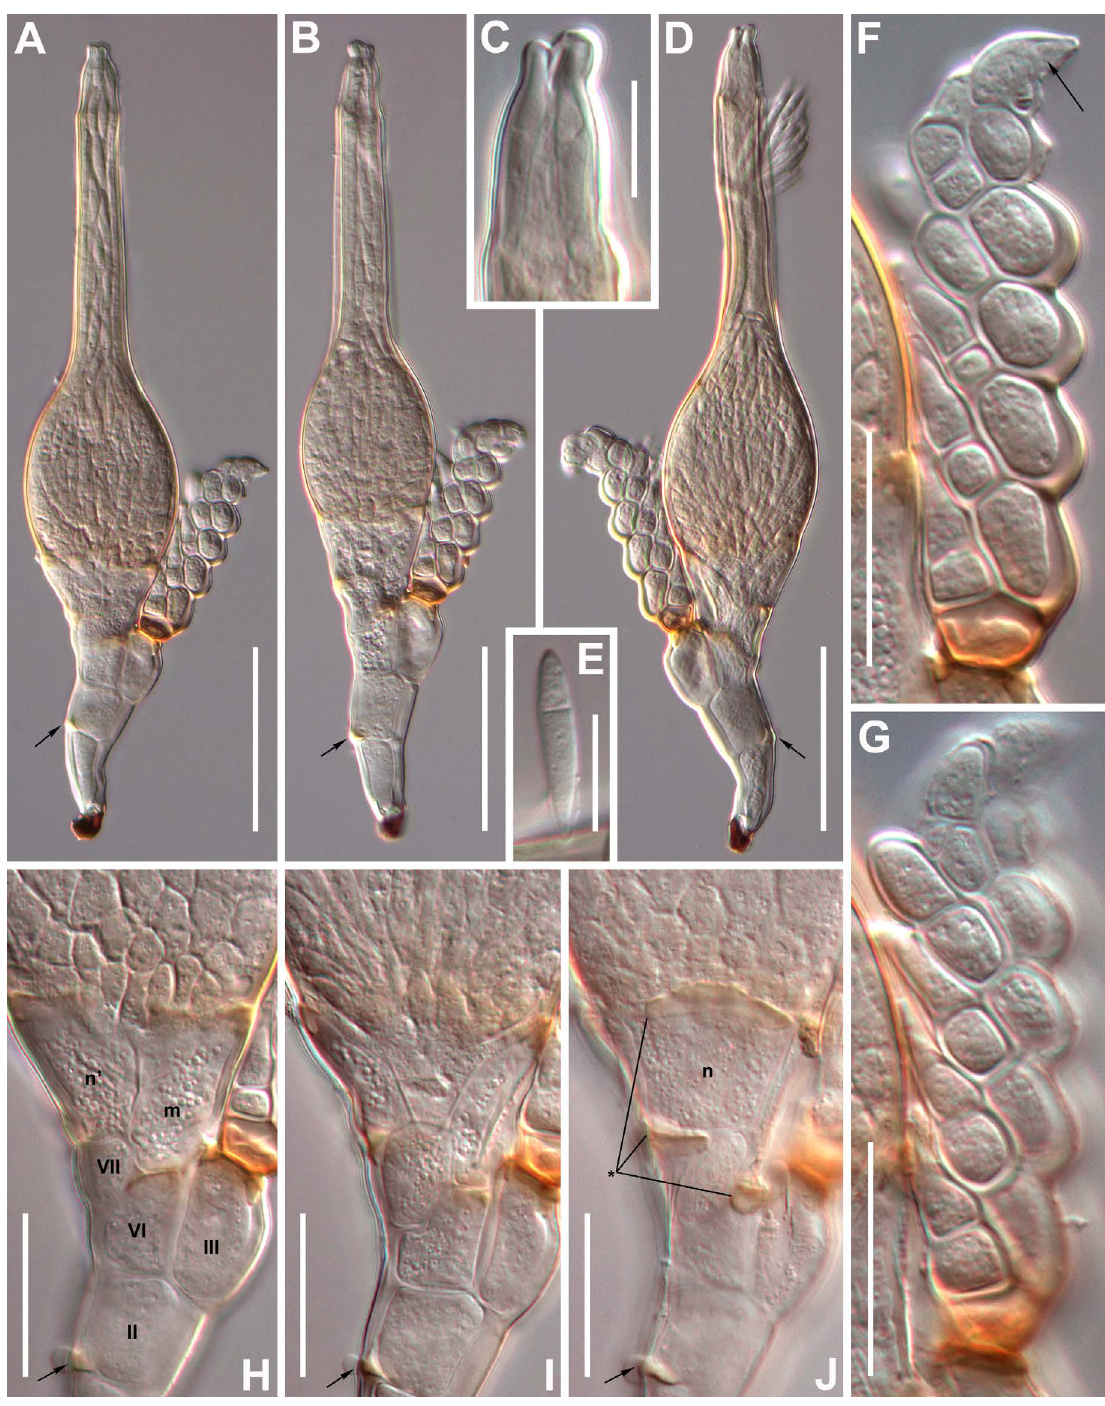
Fig. 62. Stigmatomyces thoracochaetae Santam. sp. nov. A – B , D . Mature thalli showing brown wall thickening on the lower ventral side of cell II (arrows). C . Perithecial apex in detail. E . Ascospore. F – G . Primary appendage in detail; in F the arrow points to uppermost axial antheridium-like cell which is oriented strongly backwards. H – J . Receptacle and lower area of perithecium in detail at three focusing levels, far (H), middle (I), near (J), showing cells II, III, VI, VII, m, n, n’, thickening on the lower ventral side of cell II (arrows), and brown thickenings on the walls (*). Scale bars: A–B, D = 50 µm; C, E = 10 µm; F–J = 20 µm. Photographs from slide ZMUC C-F-123733 270